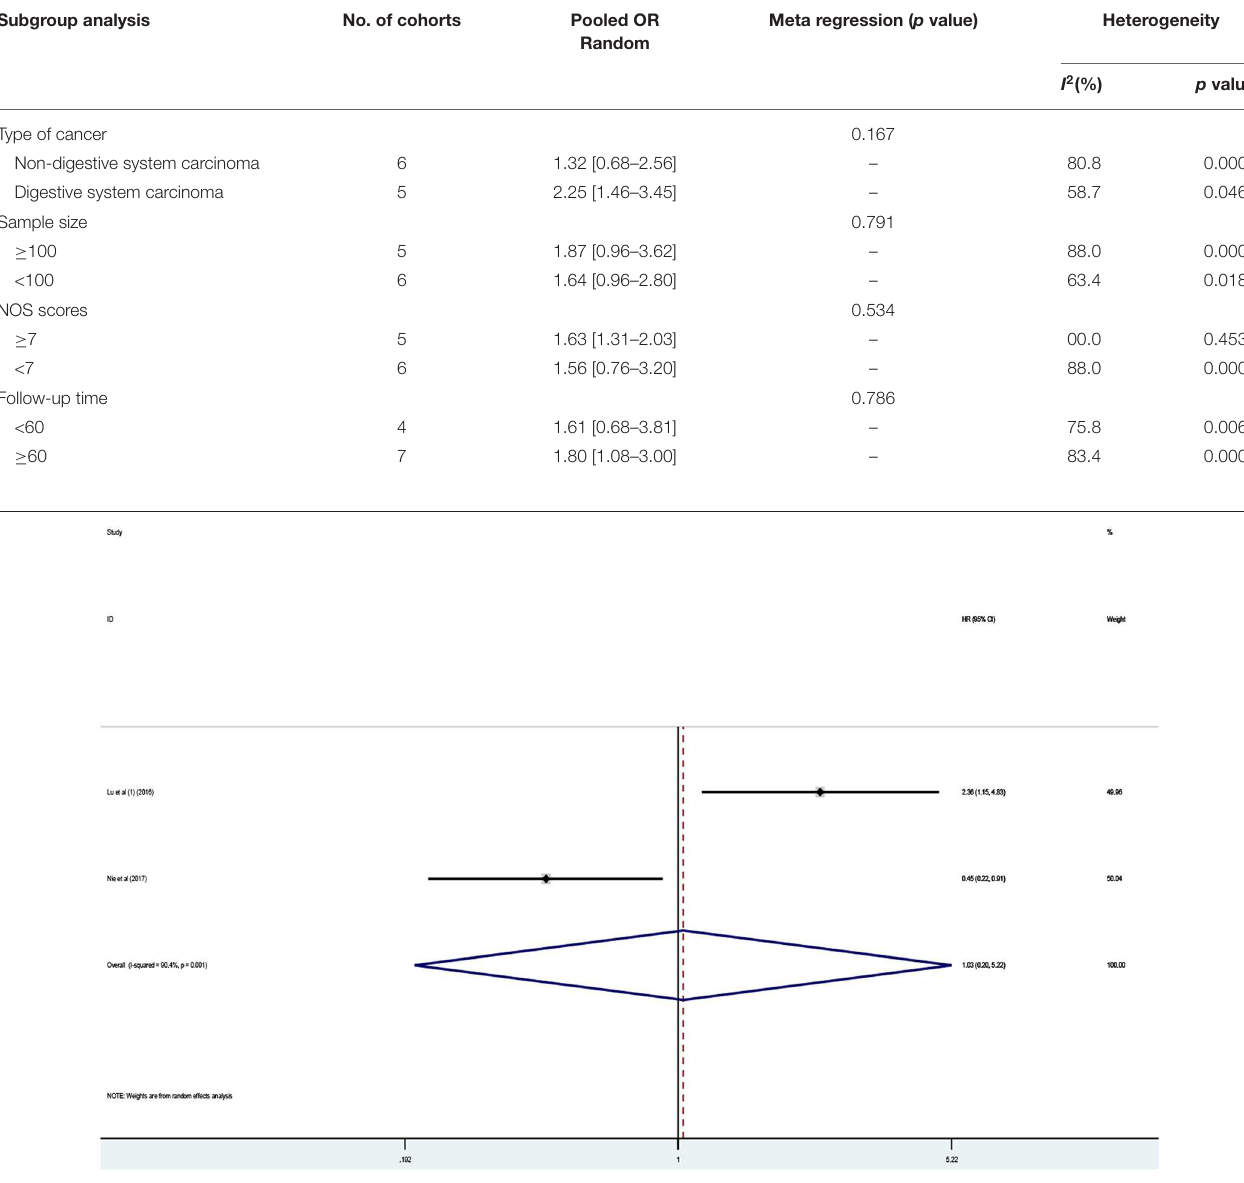
TABLE 2 | Subgroup analysis of pooled HRs for OS in cancer patients with abnormal expression level of lncRNA PANDAR. Subgroup analysis